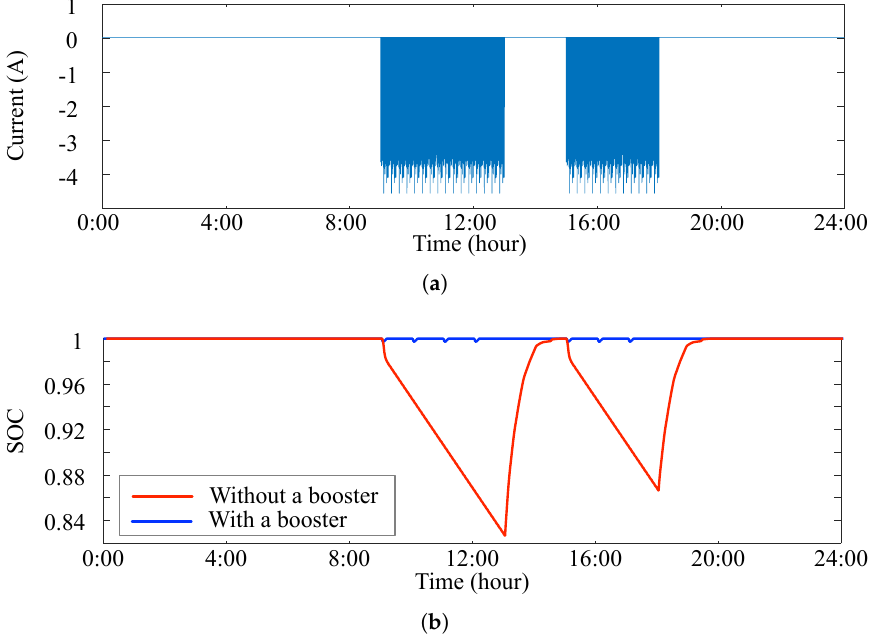
Figure 8. The daily usage of load current and the comparison of battery SOC variation between the system without a booster and with a booster. ( a ) Daily usage of load current. ( b ) Daily battery SOC